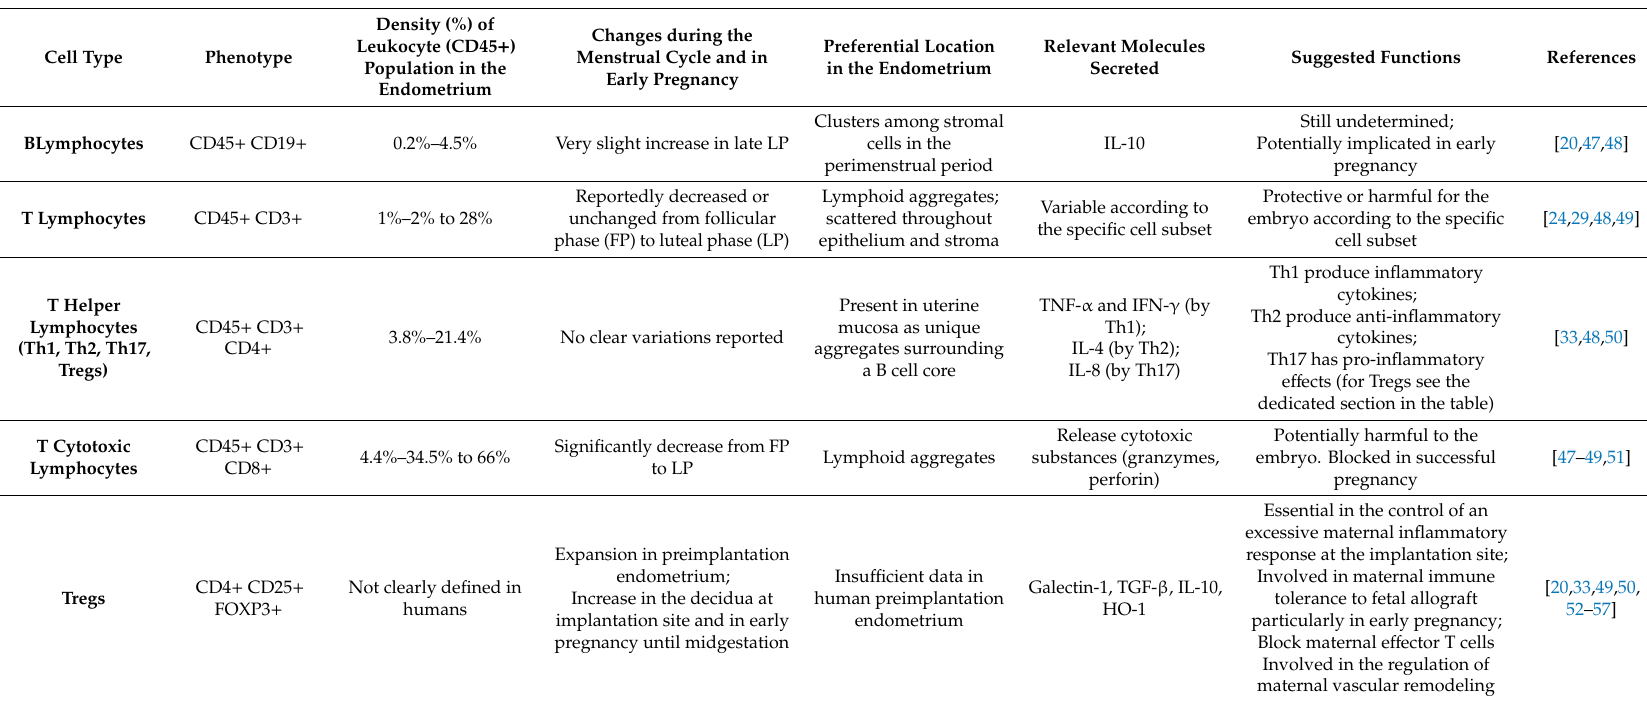
Table 3. Overview of the cells of the adaptive immune system in the endometrium and decidua with their major reproductive